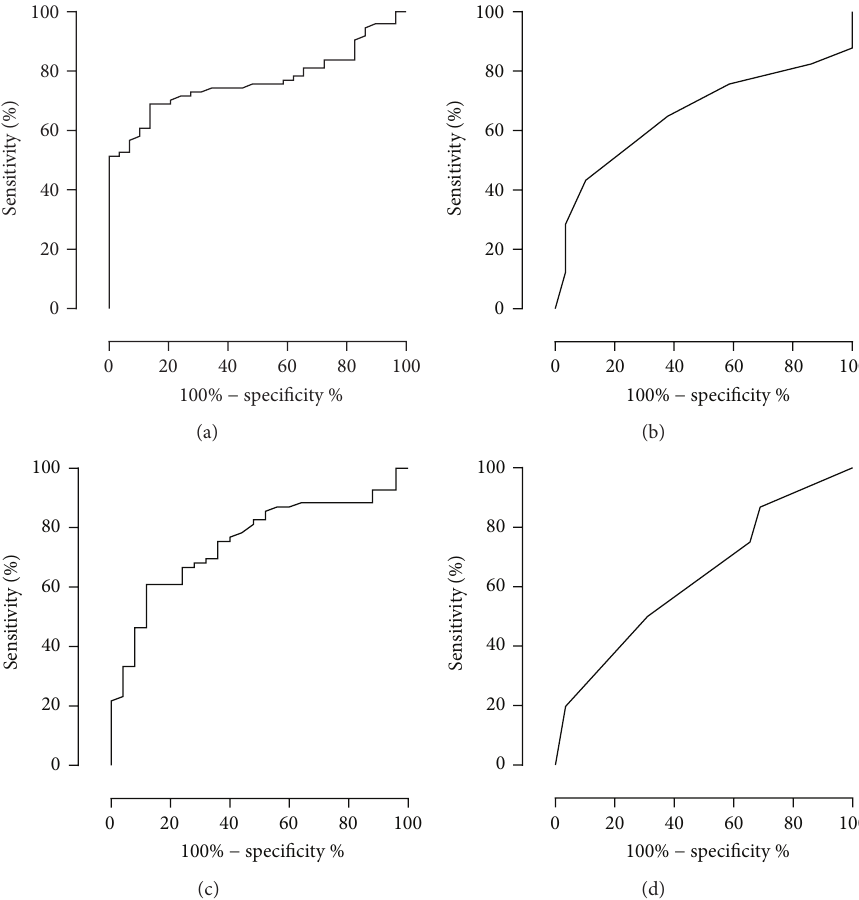
Figure 3: Efficacy of various scoring systems to differentiate NASH suspects in NAFLD. AUROCs distinguishing NASH suspects from SS suspects (see Figure 1) for Fib-4 index, AP index, NAFLD fibrosis score, and BARD score in the order of (a), (b), (c), and (d).